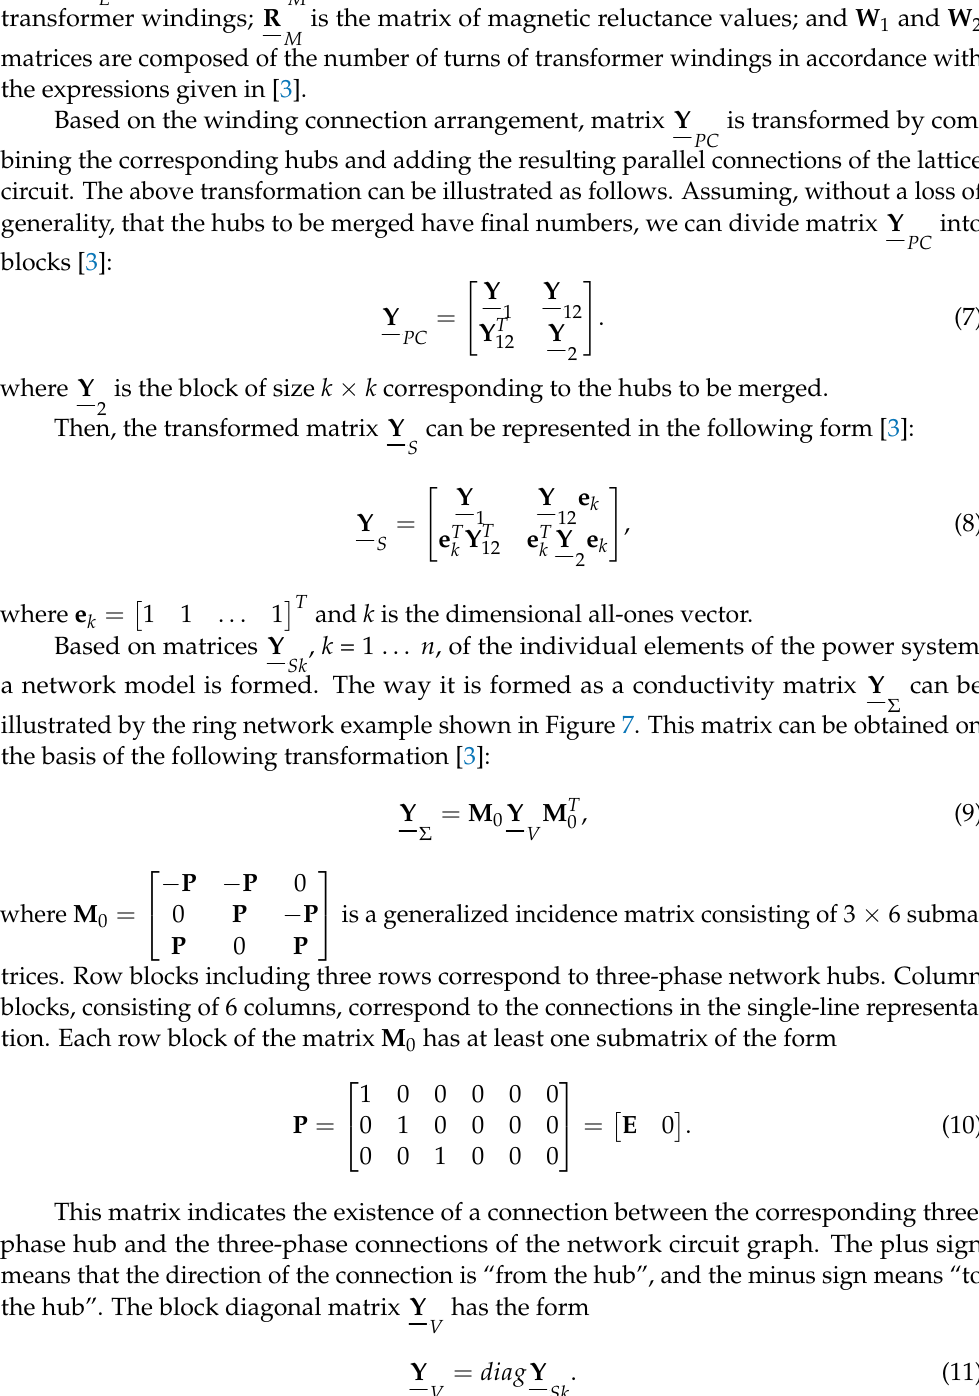
Figure 5. Original circuit of the power transmission line.